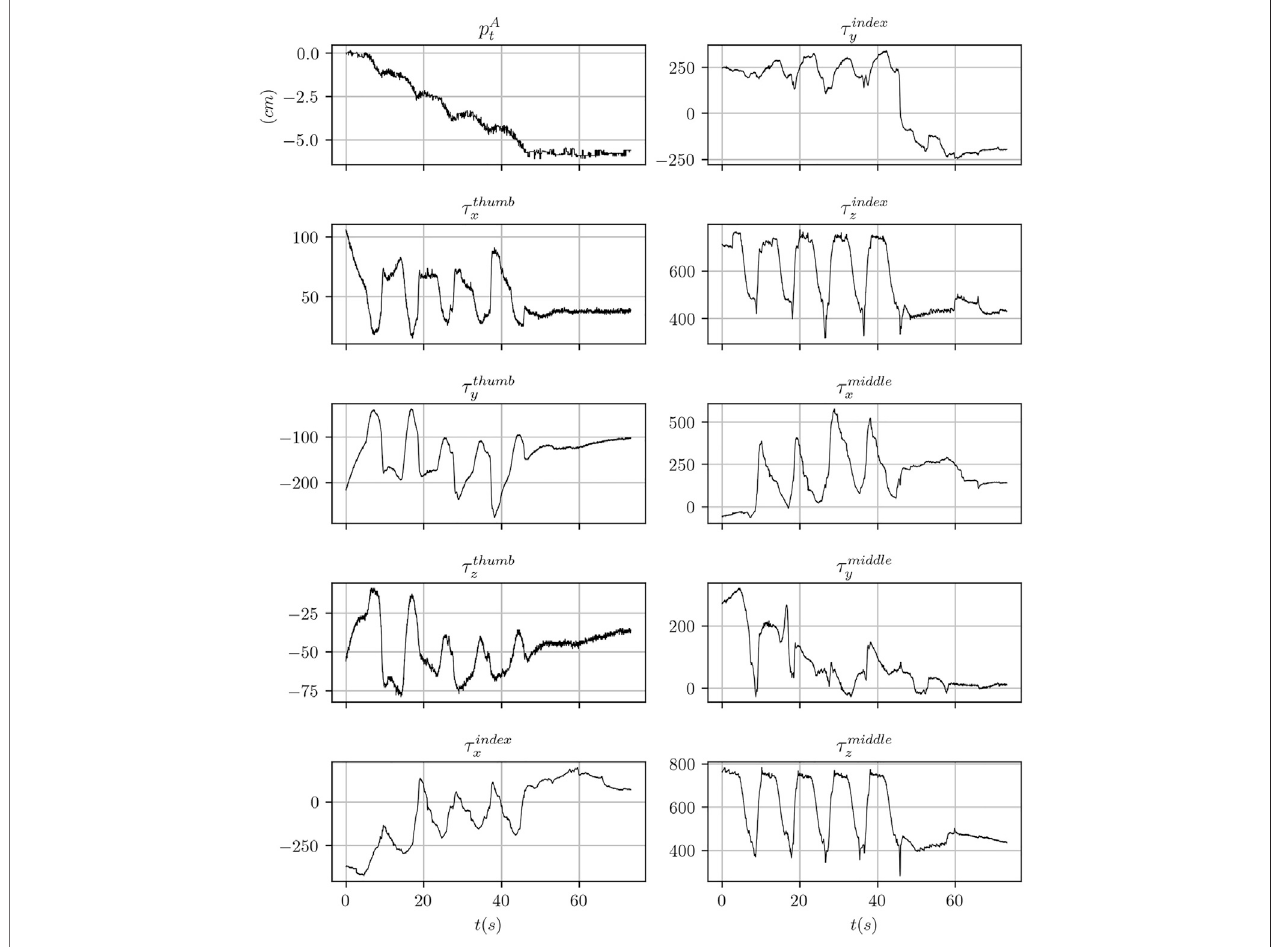
FIGURE 7 | Data traces for one of the data collection experiment performed using the mustard bottle. The tactile signals correspond to the raw sensor reading using arbitrary units.